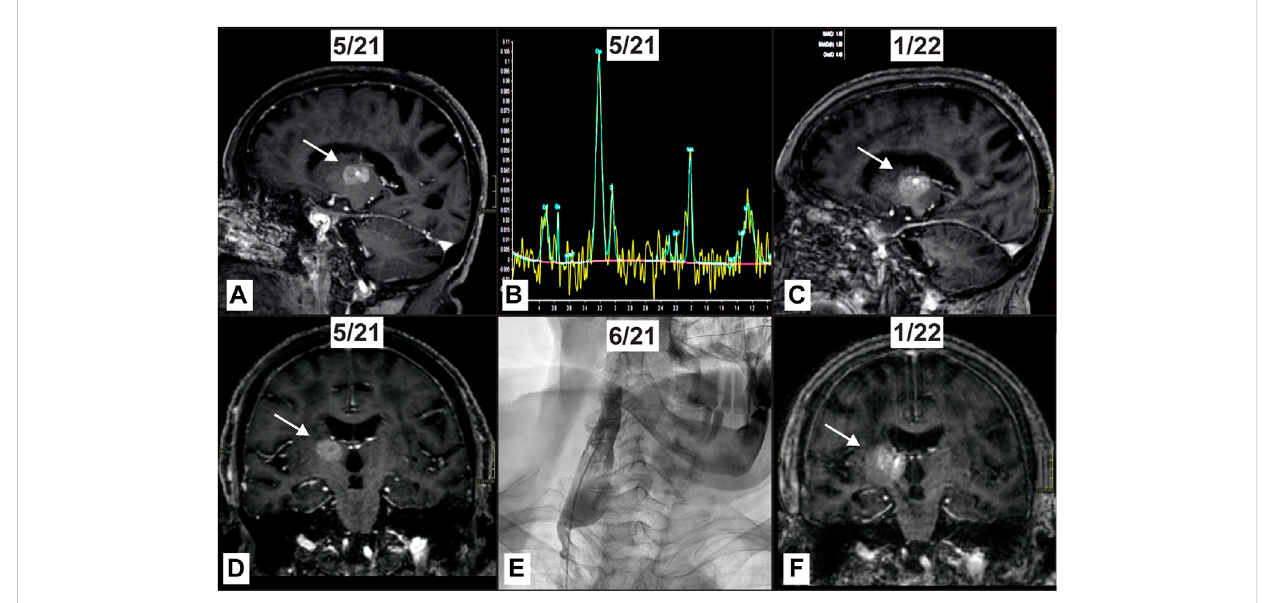
FIGURE 3 Thalamic tumor in a patient with previously resected pulmonary adenocarcinoma. High fi eld MRI shows an enhancing mass (arrow) within the right thalamus (A, D) . MR spectroscopy shows a high peak of Cho with inversion of Cho/NAA and high Cho/Cr ratios with a lipid peak, compatible with the suspicion of a glial tumor (B) . Right jugular vein where sampling has been obtained detecting ALK mutation variant (E) . High fi eld MRI acquired 8 months later reveals the mass (arrow) has increased in size (C, F)